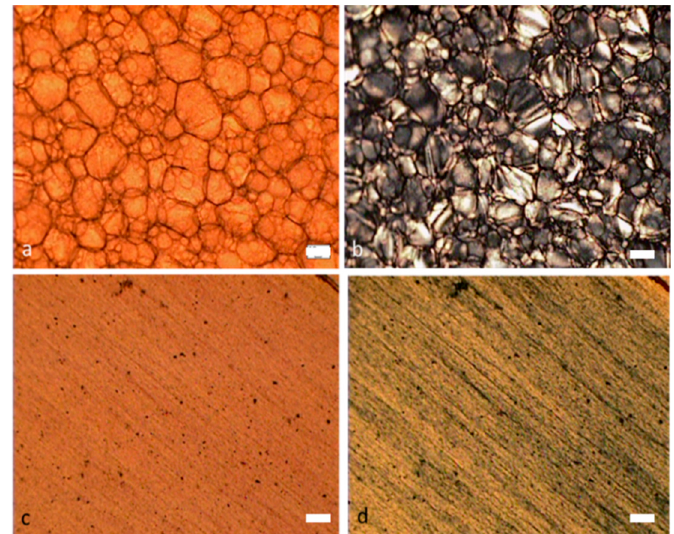
Figure 5. Optical microscope images of MWNT/CNC (2% MWNT and 98% CNC) hybrid films. ( a , c ) are normal light optical microscope images of ( a ) sedated dried CNC/MWNT hybrid film and ( c ) blade-coated dried film; ( b , d ) are polarized light optical microscope images of ( b ) sedated dried CNC / MWNT hybrid film and ( d ) blade-coated dried film. scale bar: 20 µ m.